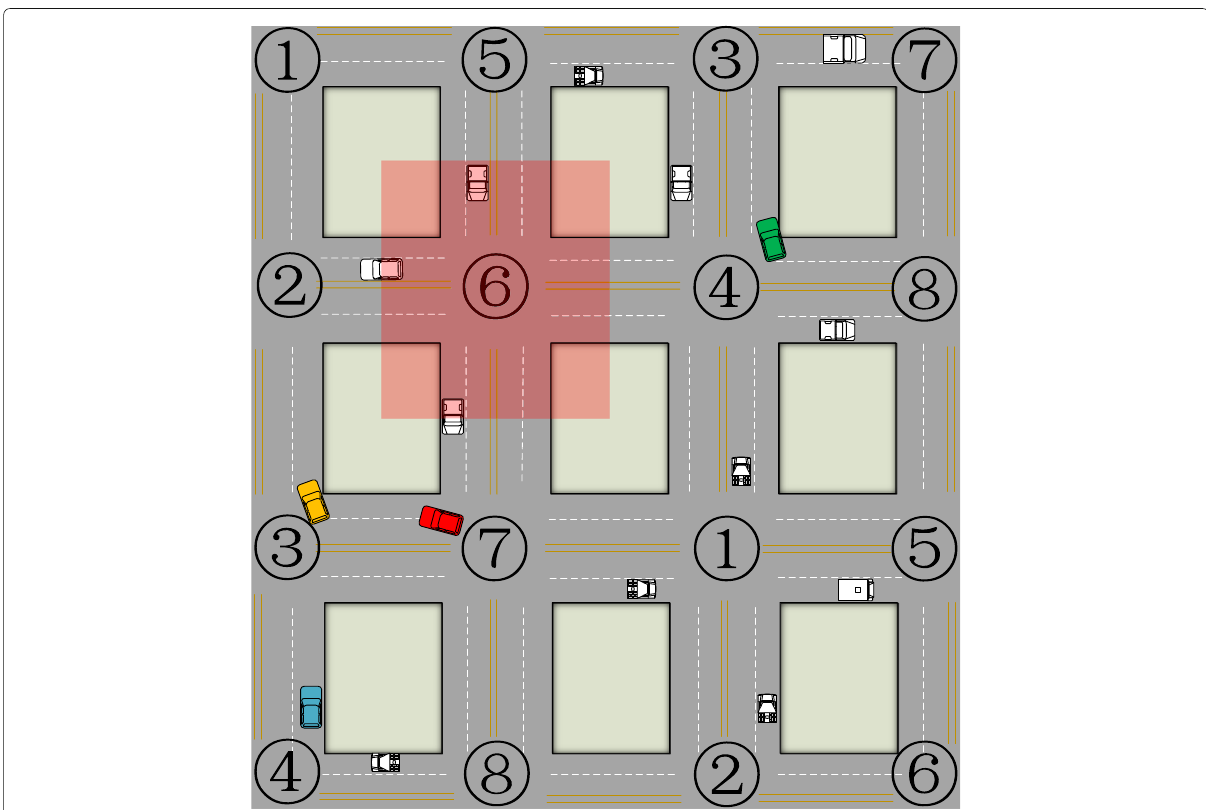
Fig. 6 The way of geographic area partition in the urban scene. The red rectangle shows the size of each geographic area. Every number in this figure represents the label of the corresponding sub resource pool of a geographic area